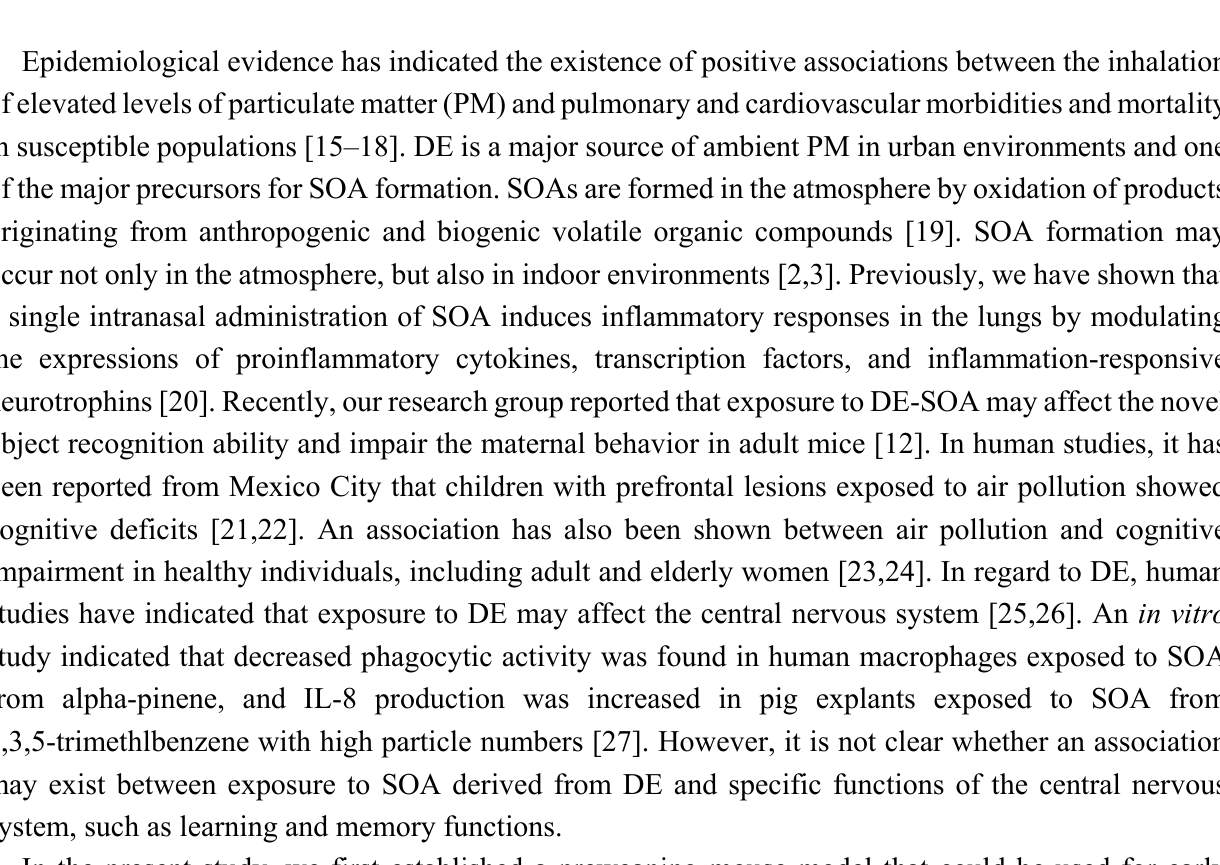
Table 1. Pearson coefficient value ( r ) showing association between TNF-a and NMDA Receptor NR1 NR2A NR2B r = −0.385 r = 0.641 r = 0.623 Control p = 0.346 p = 0.087 p = 0.099 r = −0.630 r = 0.794 r = 0.927 DE p = 0.050 p = 0.006 p = 0.000 r = −0.732 r = 0.758 r = 0.638 DE-SOA p = 0.016 p = 0.011 p = 0.047 r = 0.248 r = 0.745 r = 0.874 Gas p = 0.489 p = 0.013 p =